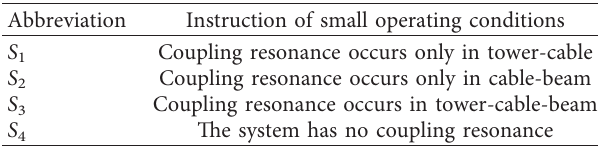
Table 5: Instruction of each working condition